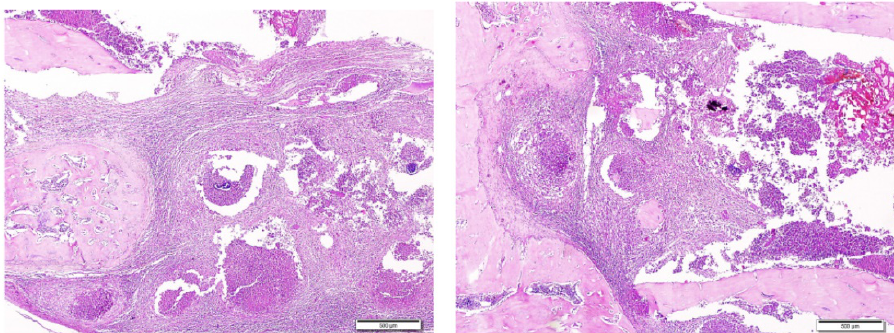
Figure 2: a: Wide osteomyelitis region showing high grade inflammation (grade 3). In the middle, intensive accumulation of polymorphonuclear leucocytes and mononuclear inflammatory cells and also wide necrosis and abscess foci seen. b: Wide destruction of bone lamellae in these foci. H&E, x400.